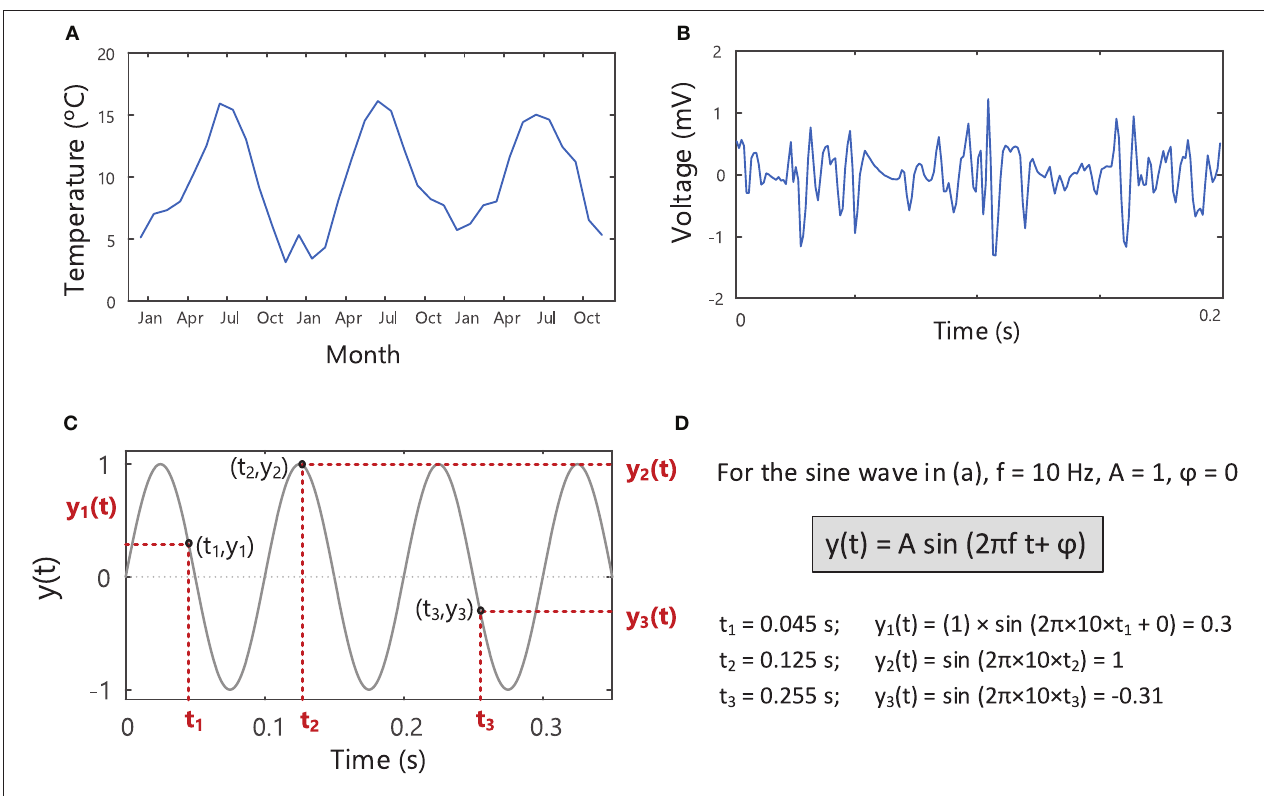
FIGURE 3 | Signals describing the variation of a measurable quantity over time, e.g., (A) temperature and (B) voltage. (C) A sine wave with an amplitude of 1, frequency of 10Hz and phase of zero, showing the variation in the signal over time. The instantaneous value of the sine wave, y(t), shown in (C) can be found at each point in time, t, using the equation in (D) . See Example (i) in Tutorial Code.